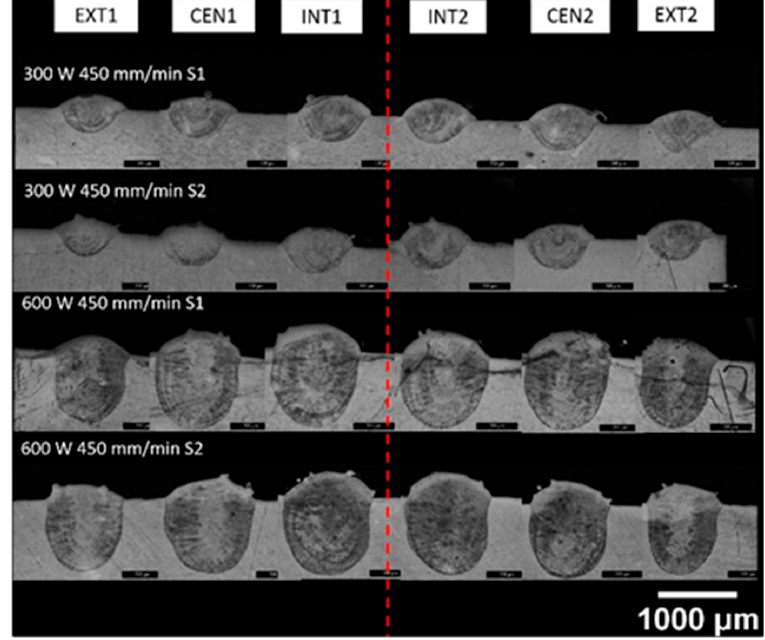
Figure 4. Optical micrographs of cross-sections of the circular contour samples.